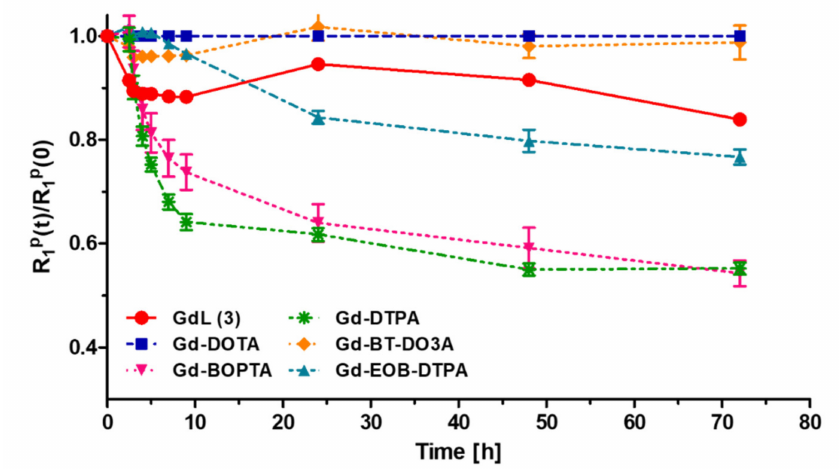
Figure 2. Evaluation of longitudinal relaxation rates R 1 P (t) / R 1 P (0) as a function of time (up to 72 h) for GdL (3) and various magnetic resonance (MR) contrast agents (Gd-BT-DO3A, Gd-DTPA-EOB, Gd-DTPA, Gd-DOTA, and Gd-DTPA-BOPTA) using a 3.0 T MR scanner at 294